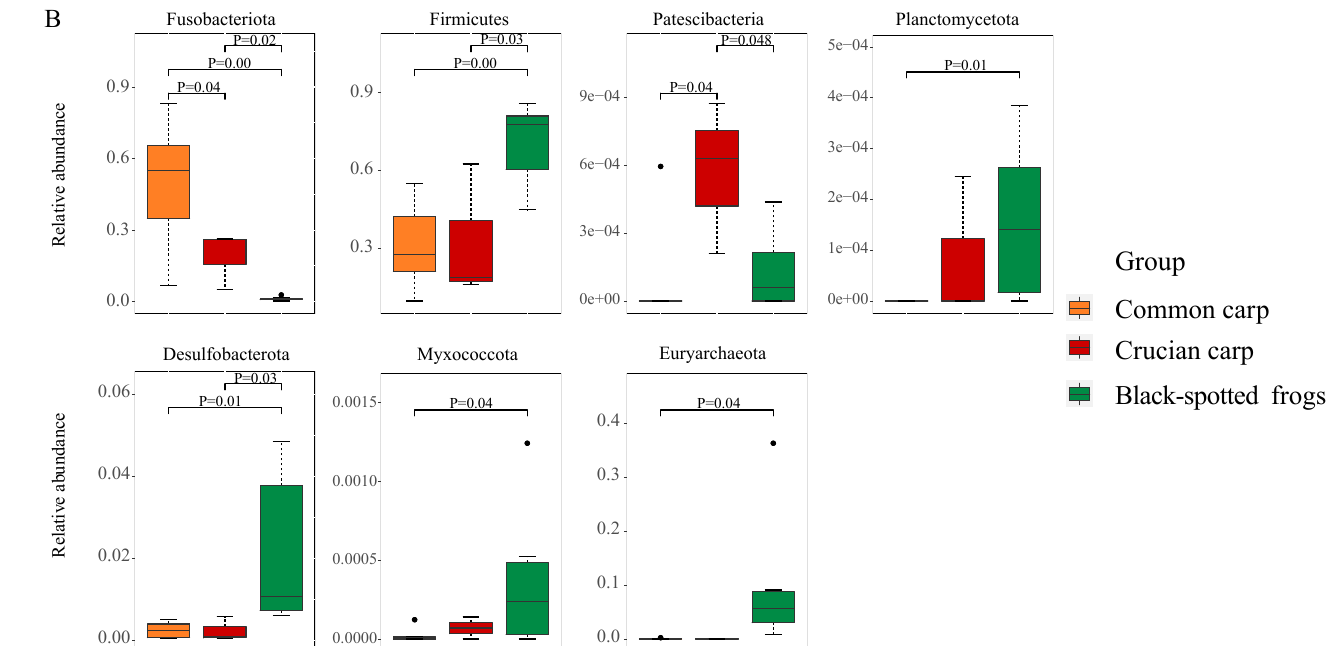
Figure 1. Microbial composition of the common carp, crucian carp, black-spotted frogs, and water samples. ( A ) The relative abundance of the top 10 bacterial phyla in the GI tracts of common carp, crucian carp, black-spotted frog, and water environment. ( B ) Box-and-whisker plots for the relative abundance of six bacterial phyla with significant differences ( p < 0.05) between the four groups based on the Metastat